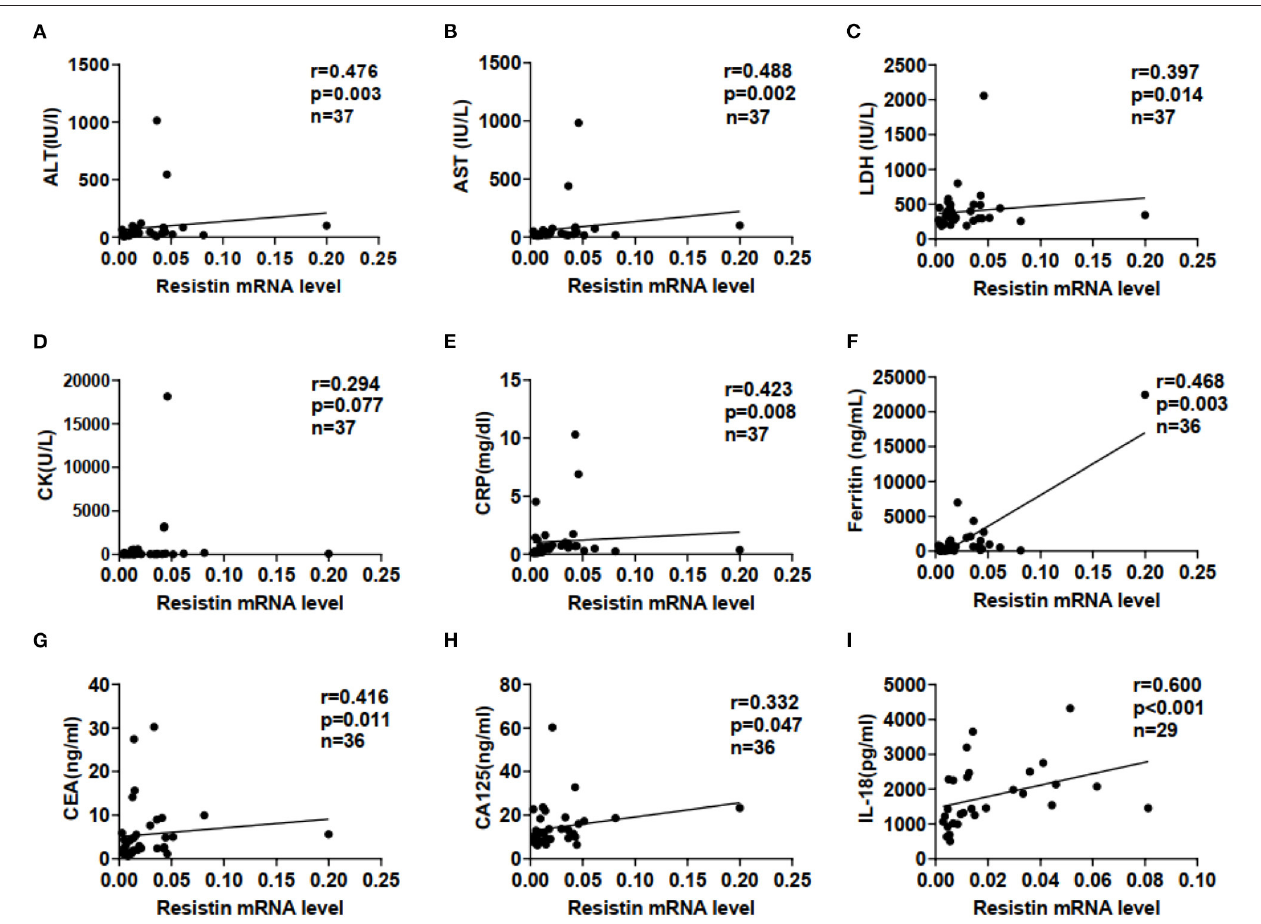
FIGURE 2 | Elevated resistin mRNA levels in PBMCs were associated with laboratory data for patients with DM-ILD. Correlation of resistin mRNA levels in PBMCs with (A) alanine aminotransferase (ALT), (B) aspartate aminotransferase (AST), (C) lactate dehydrogenase (LDH), (D) creatine kinase (CK), (E) C-reactive protein (CRP), (F) ferritin, (G) carcinoembryonic antigen (CEA), (H) carbohydrate antigen (CA)125, and (I) interleukin-18 (IL-18) levels. Correlations were assessed using Spearman’s correlation analyses.